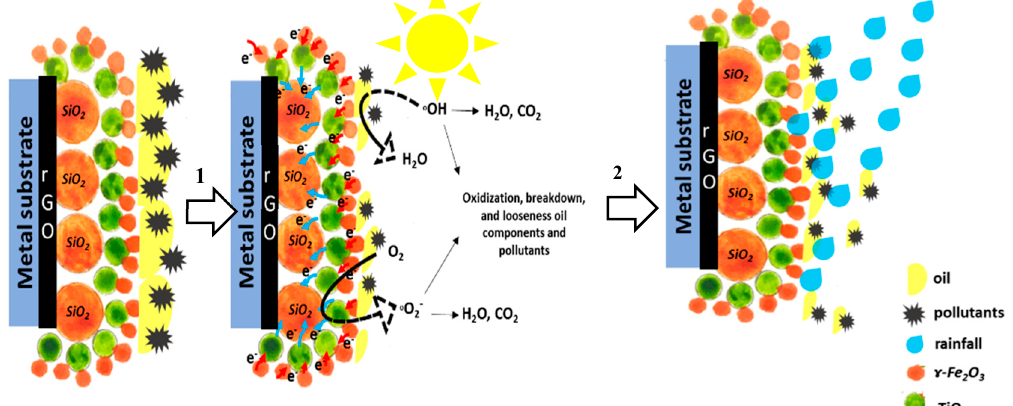
Figure 15. Schematical description of self-cleaning from oil, soil, and pollutants by the photoactive TSF 32 G (or TSF) coated layers.